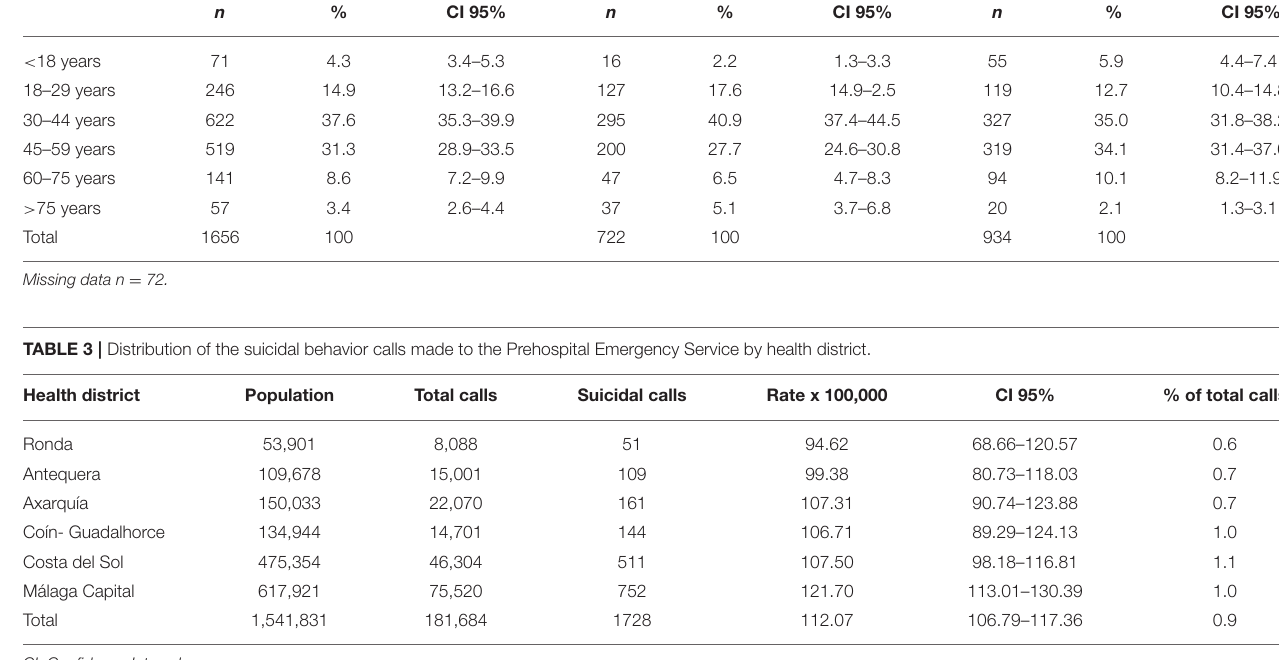
TABLE 2 | Distribution of the suicidal behavior calls made to the Prehospital Emergency Service according to age and sex. Age groups